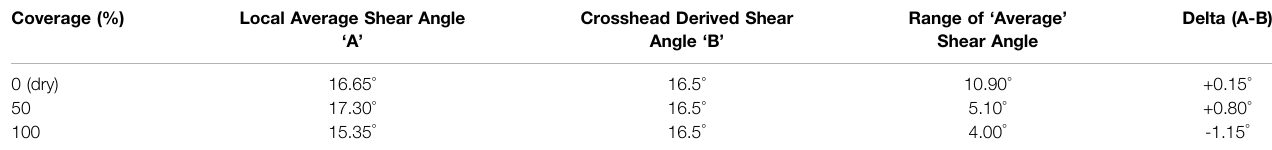
TABLE 3 | Shear angle measurements by coverage level as measured from video gauge frame and also derived based on crosshead displacement. Coverage (%)